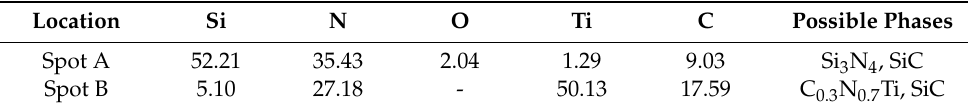
Figure 3. Polished surface of Si 3 N 4 ceramics with different content of Ti 3 SiC 2 sintered at 1700 °C: ( a ) 5 wt.% Y 2 O 3 -2 wt.% Al 2 O 3 , ( b ) 1 vol.% Ti 3 SiC 2 , ( c ) 3 vol.% Ti 3 SiC 2 , ( d ) 5 vol.% Ti 3 SiC 2 , ( e ) 10 vol.% Ti 3 SiC 2 , ( f ) 15 vol.% Ti 3 SiC 2 , ( g ) 20 vol.% Ti 3 SiC 2 , ( h ) EDS spectra at spot A and B. Table 2. EDS chemical analysis (at.%) at different positions in Figure 3g.